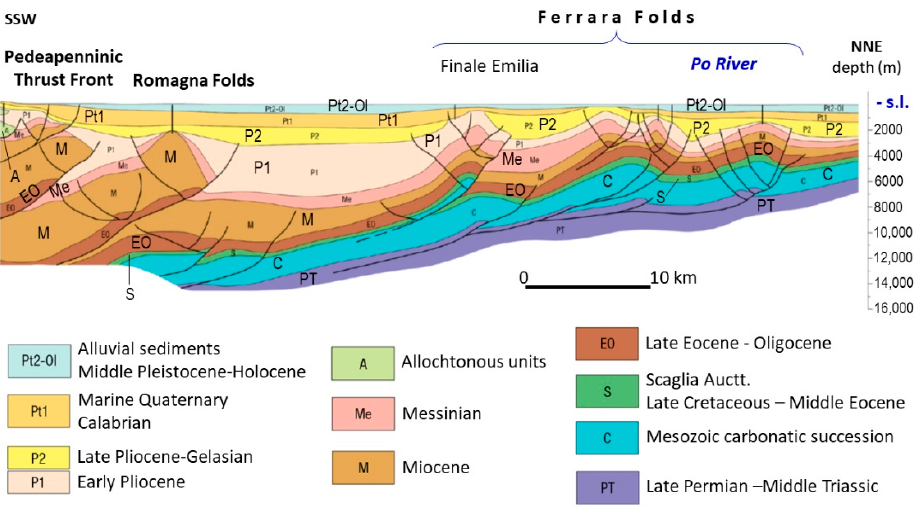
Figure 3. Geological cross-section from the Bologna Apennines to the Po River [16]; trace in Figure 4.